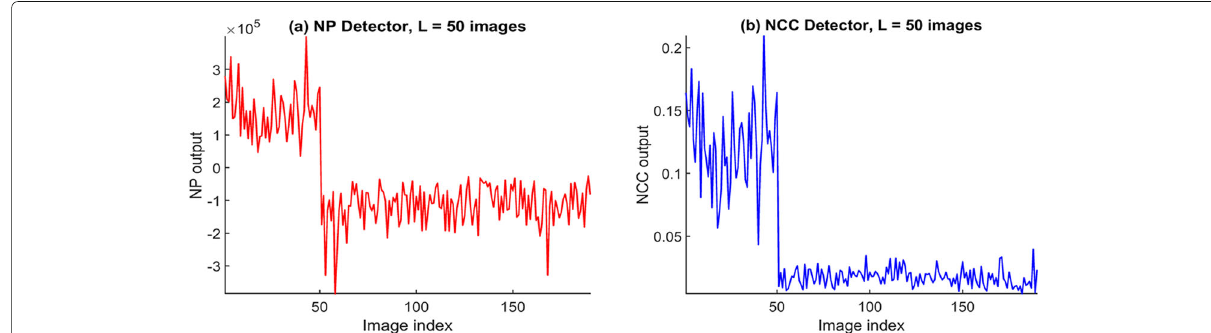
Fig. 8 Detection statistics for the Neyman-Pearson detector (14) (a) and the Normalized Correlation coefficient detector (19) (b) on a set of 190 JPEG-compressed images (Nikon D7000 camera), where the PRNU is estimated from the first 50 images. The performance of both detectors decreased slightly, as the compression process enhances the denoising. In both cases, the two levels can still be